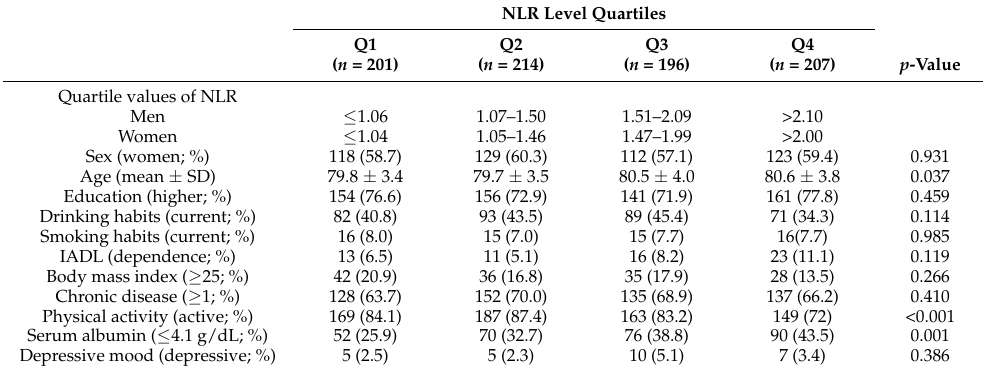
Table 2. Participant characteristics as a function of NLR level.